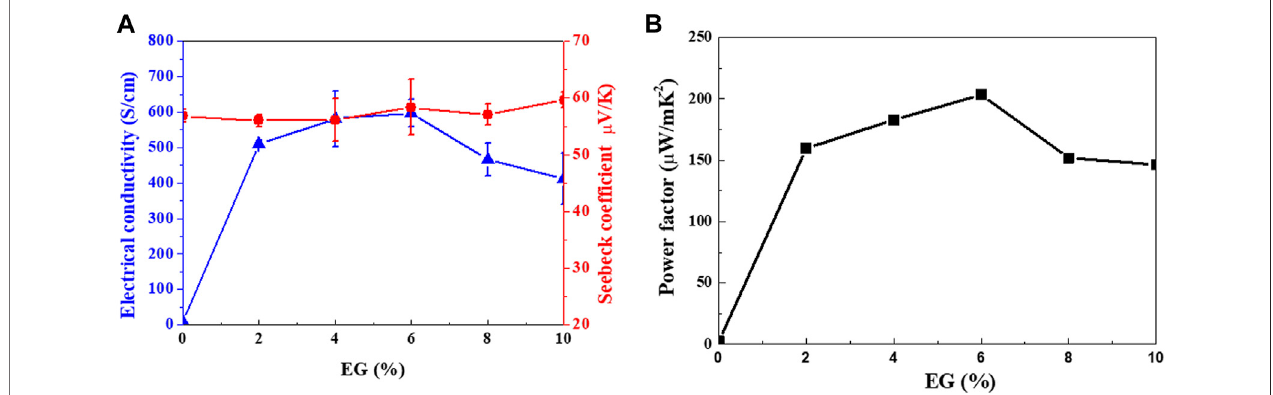
FIGURE 7 | (A) Seebeck coef fi cient and electrical conductivity, and (B) power factor of the Se wire/PEDOT:PSS composite as functions of ethylene glycol (EG) doping concentrations.